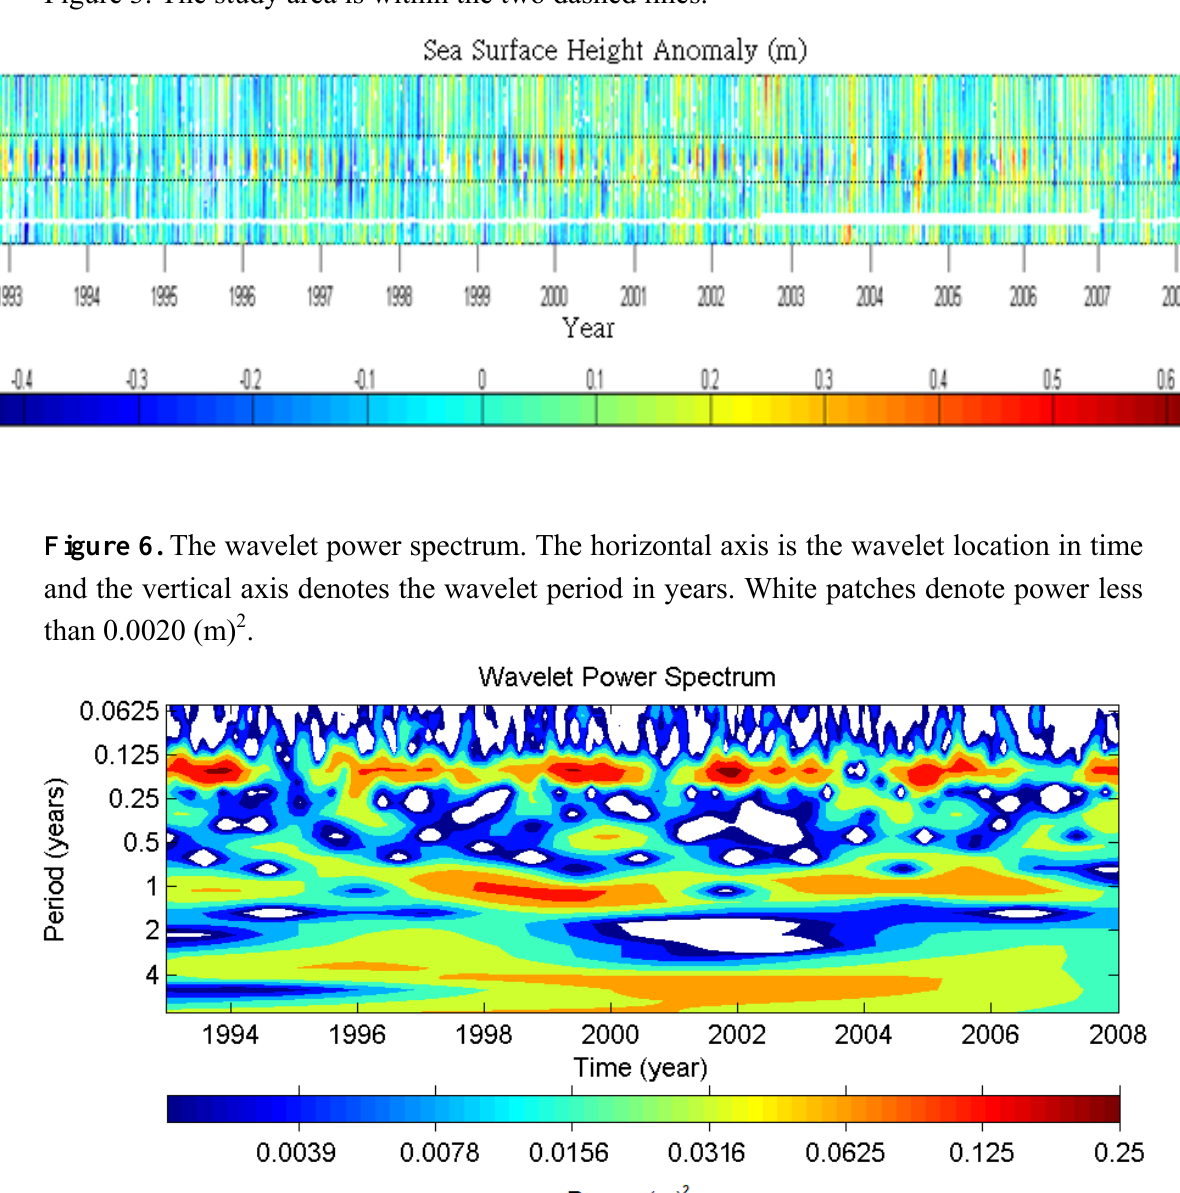
Figure 5. Time series of SSHA of T/P and Jason-1 along track 240 across the upwelling area. The vertical axis is the region of T/P track from northwest to southeast as shown in Figure 3. The study area is within the two dashed lines.